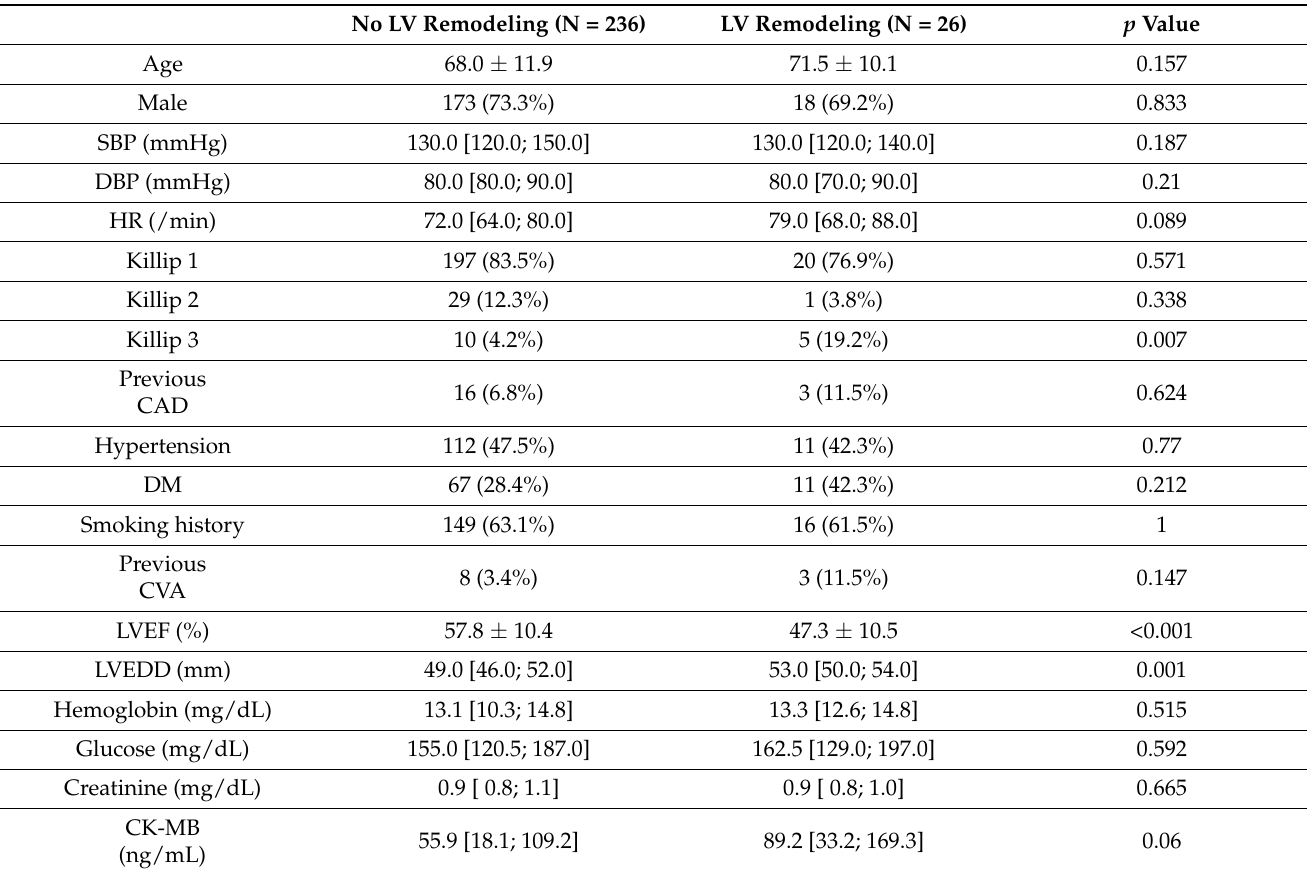
Table 1. Baseline characteristics according to LV